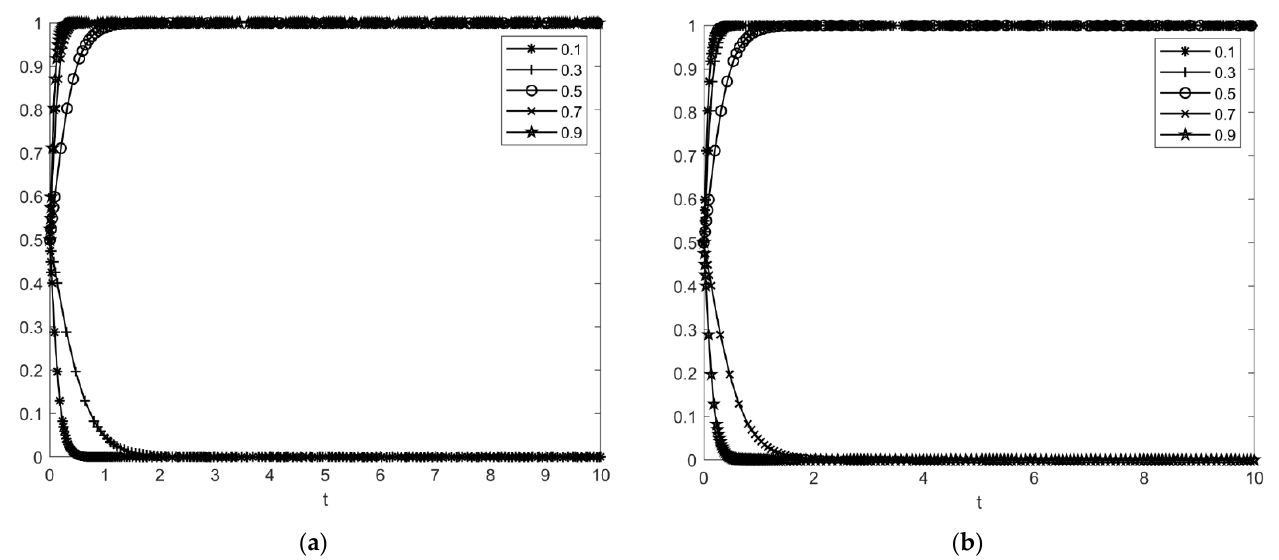
Figure 8. The effect of γ on the cooperation strategy for construction enterprises 1 and 2. ( a ) con- struction enterprise 1; ( b ) construction enterprise 2.